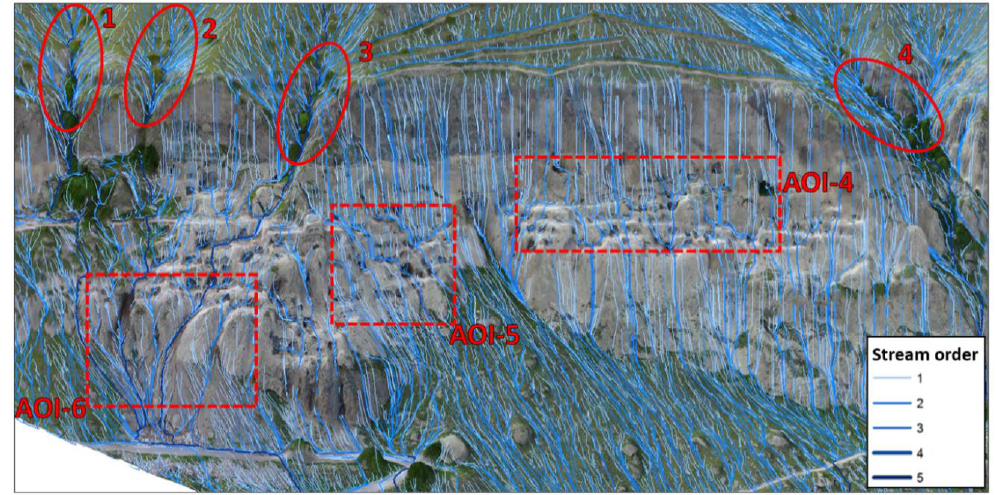
Figure 10. Front view of the modeled drainage network on the Vardzia slope 3D surface.